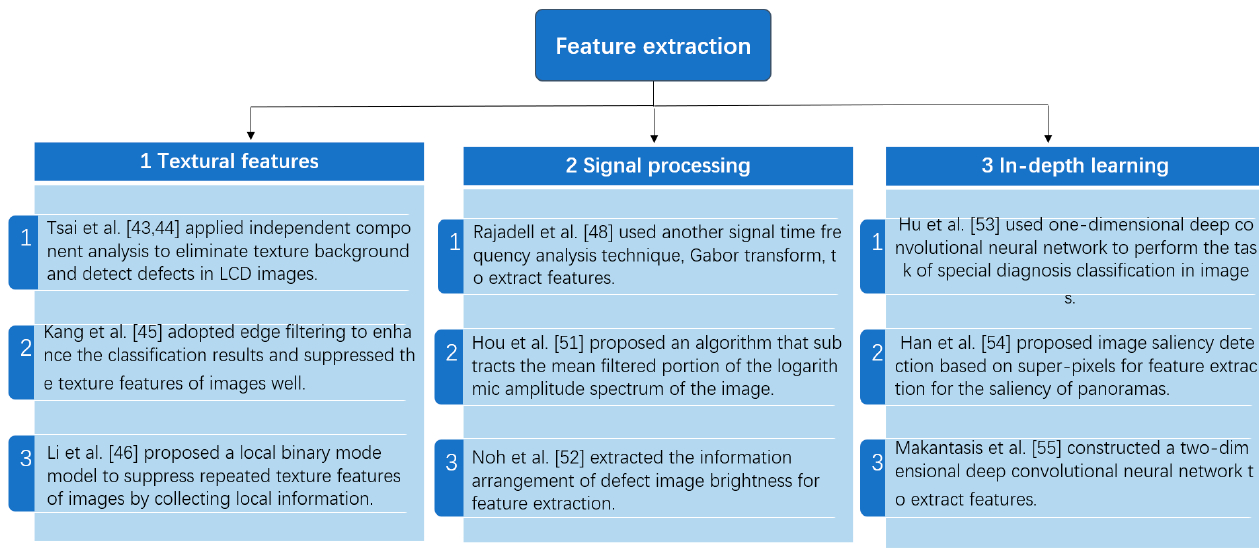
Figure 9. Comparative of linear dimension reduction and nonlinear dimension reduction.